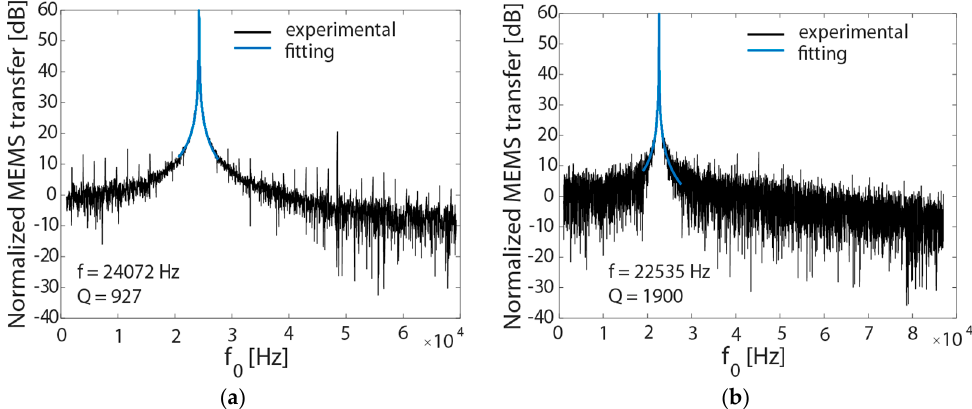
Figure 2. Experimental measurement of the quality factor and of the natural frequencies of the ( a ) OP and ( b ) IP modes of the FM pitch